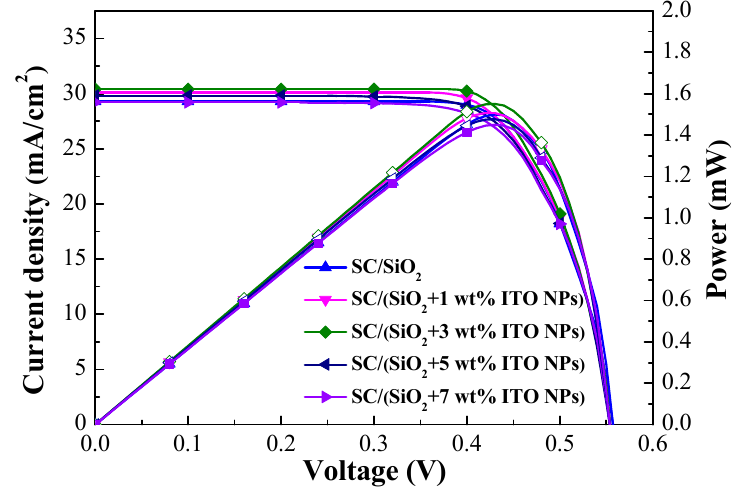
Figure 10. Photovoltaic J–V curves of the cell coated with a layer of SiO 2 (without ITO-NPs) and cells with a layer of SiO 2 containing various concentrations of ITO-NPs.